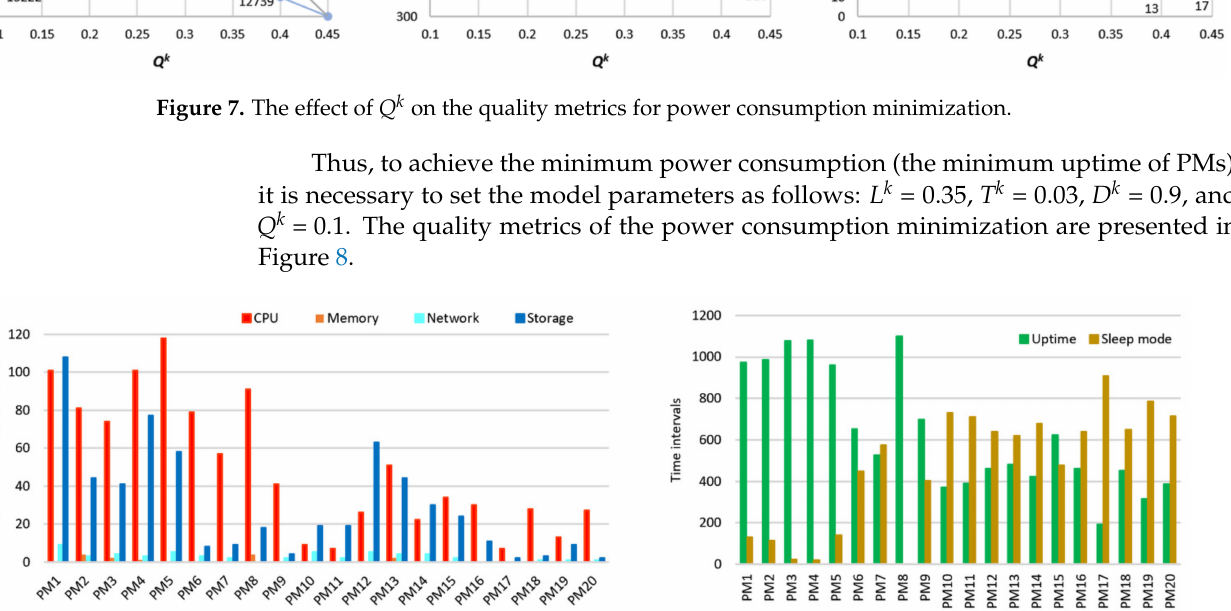
Figure 8. The quality metrics of the power consumption minimization after a simulation